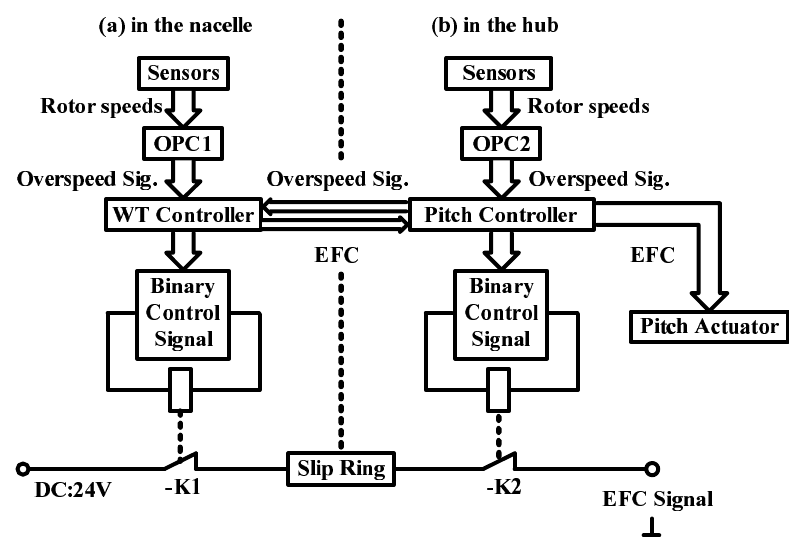
Figure 11. The improved OPC scheme.